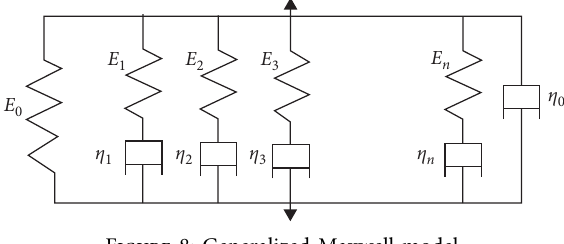
Figure 8: Generalized Maxwell model.